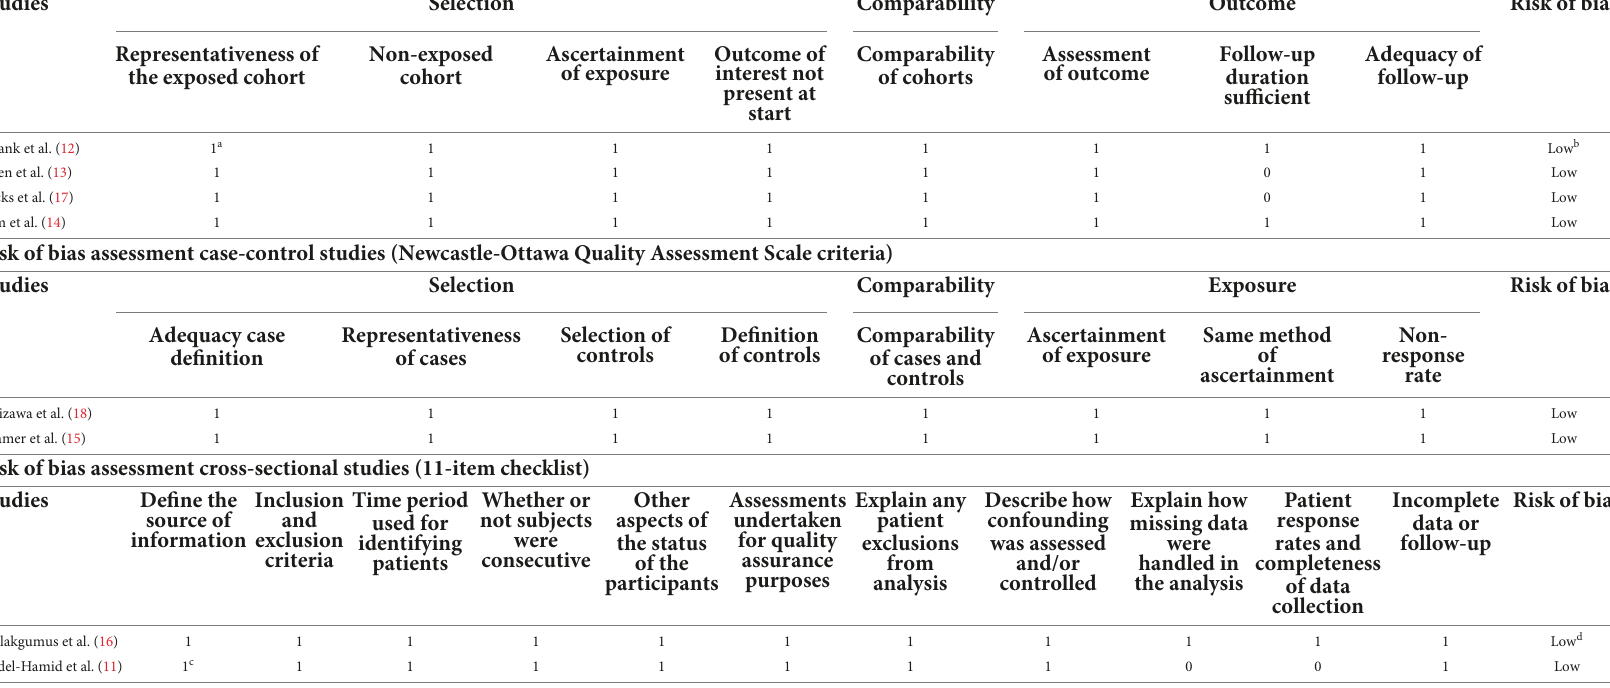
TABLE 2 Risk of bias assessment cohort studies (Newcastle-Ottawa Quality Assessment Scale